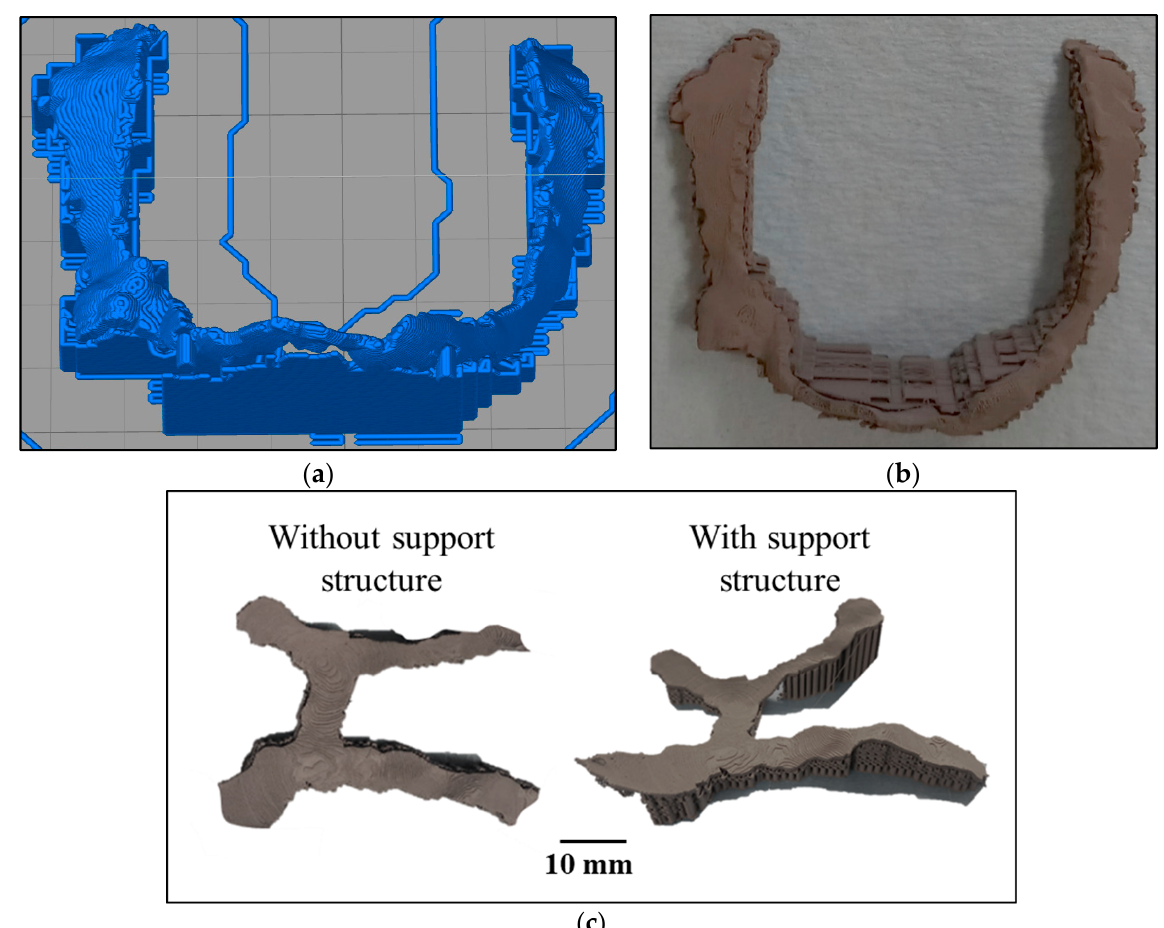
Figure 4. ( a ) Build setup showing sliced model, toolpath support structure of the middle part; ( b ) MF 3 -printed green part; ( c ) printing without appropriate support structure failed and an optimal support led to successful printing of the RH part.